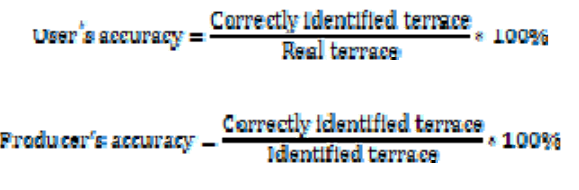
Figure 6. There are two types of misclassification: terrace samples of test set (real terrace) are not identified as terrace and non-terrace are categorized as terrace. User’s accuracy and producer’s accuracies correspond to these misclassification types respectively: